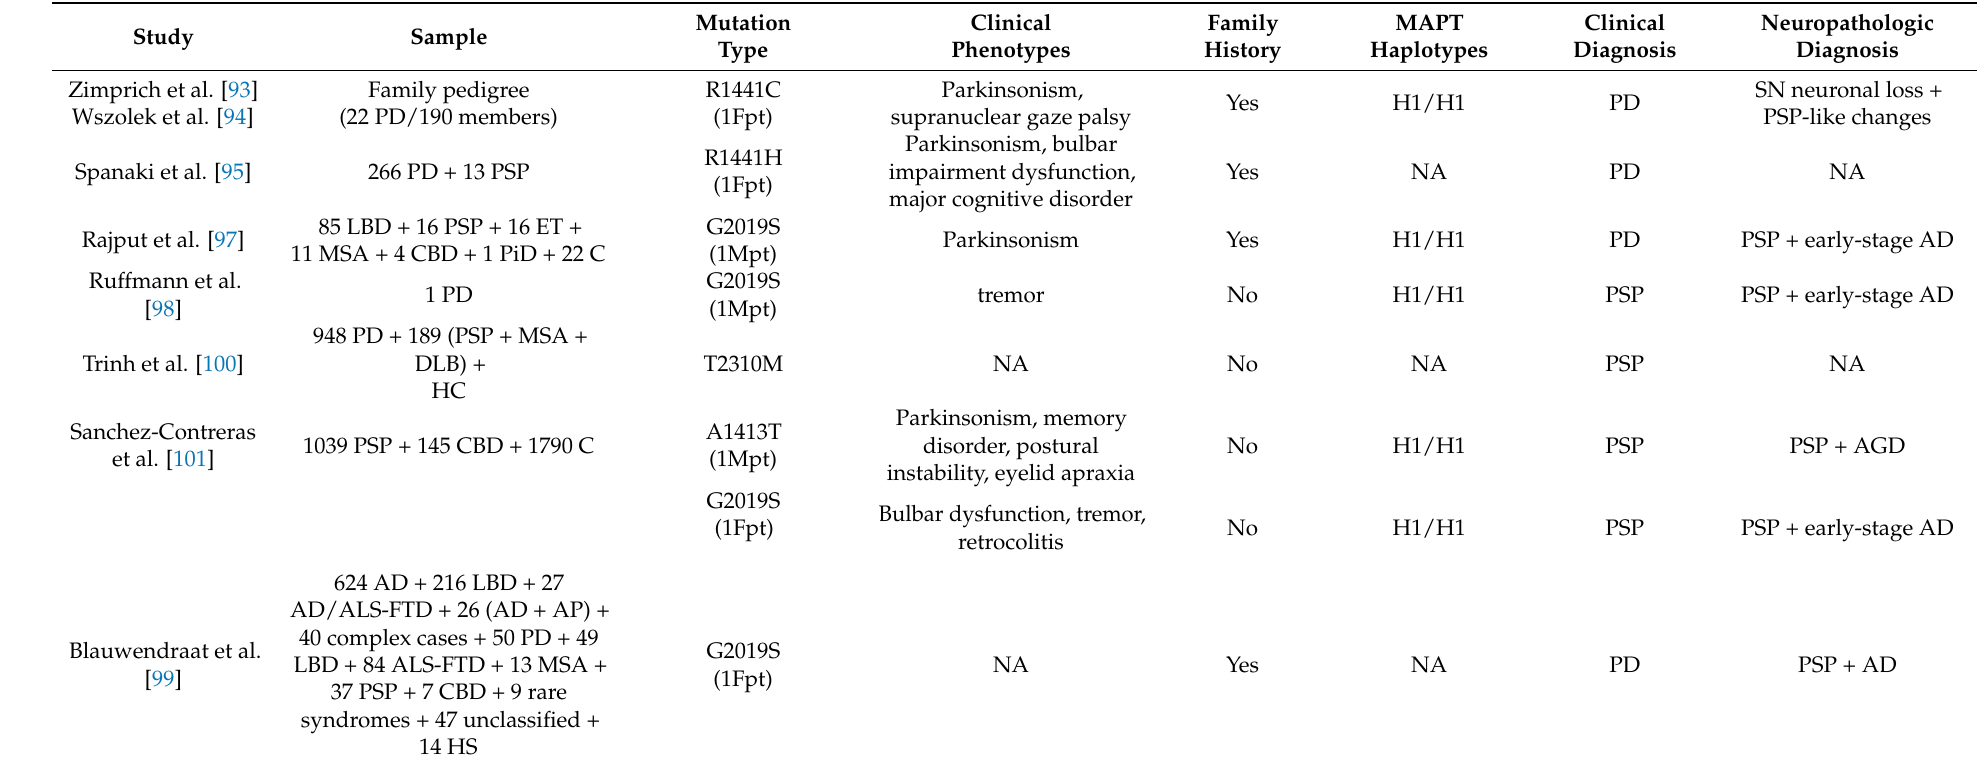
Table 4. LRRK2mutations of PSP-mimicker